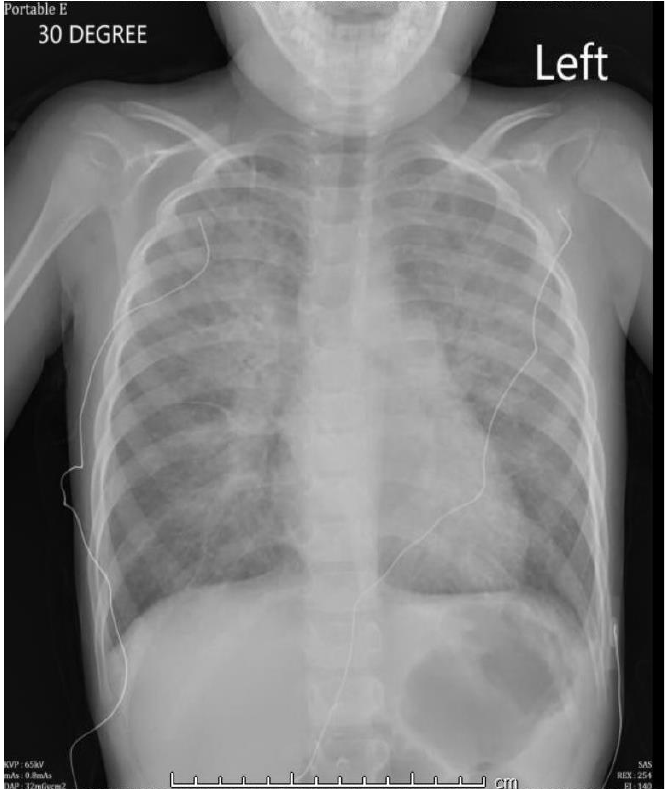
Image 2. Initial chest radiograph demonstrating pulmonary edema.